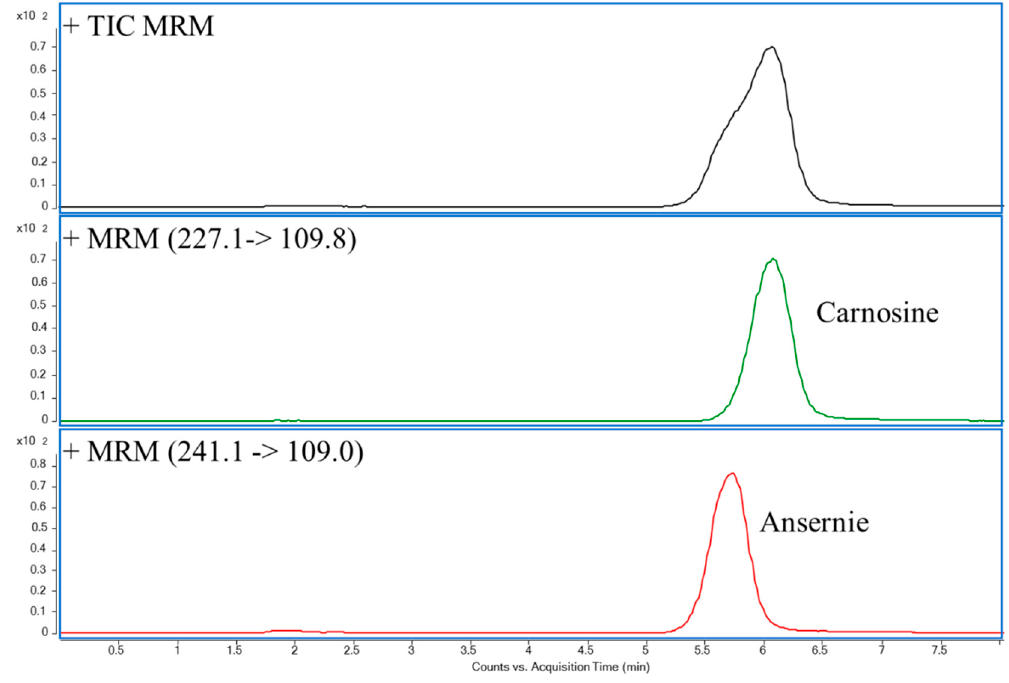
Figure 1. The MRM chromatograms of anserine and carnosine.